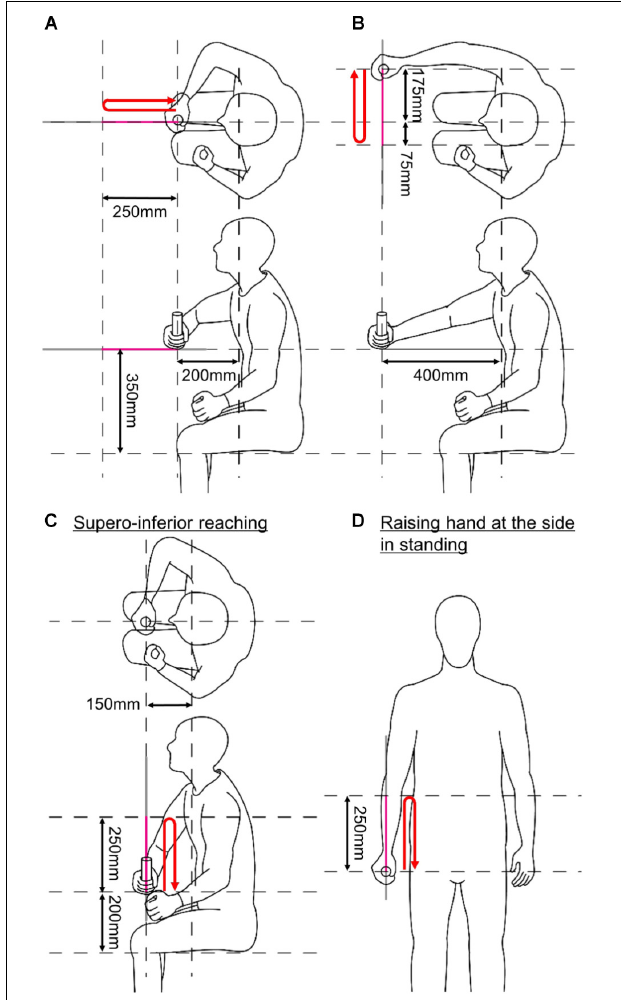
FIGURE 5 | Initial postures of the four upper limb motions. (A) Anteroposterior reaching. (B) Mediolateral reaching. (C) Superoinferior reaching. (D) Raising a hand at the side in standing. Red arrows indicate reaching trajectories of a subject in each